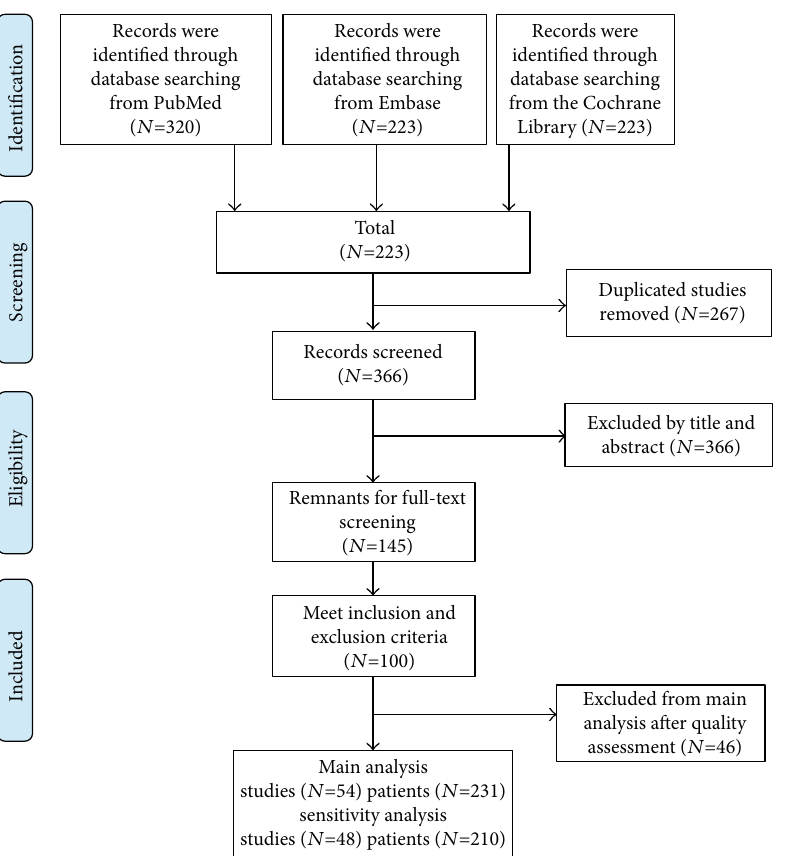
Figure 1: Flow diagram based on PRISMA statement